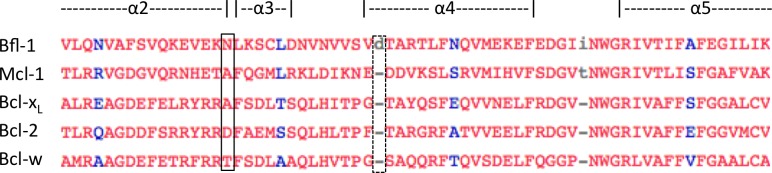
Multiple-sequence alignment of helices 2–4 of human anti-apoptotic Bfl-1 homologs.Bfl-1 has an amino-acid insertion that may contribute to the widened binding groove between helices 3 and 4 (dotted box). Additionally, there is an asparagine that is unique to Bfl-1 at the elbow between helices 2 and 3 that forms a hydrogen bond with FS2 (solid box). This interaction may contribute to the Bfl-1 specificity of FS2. Sequence alignment made using Cobalt (Papadopoulos and Agarwala, 2007).